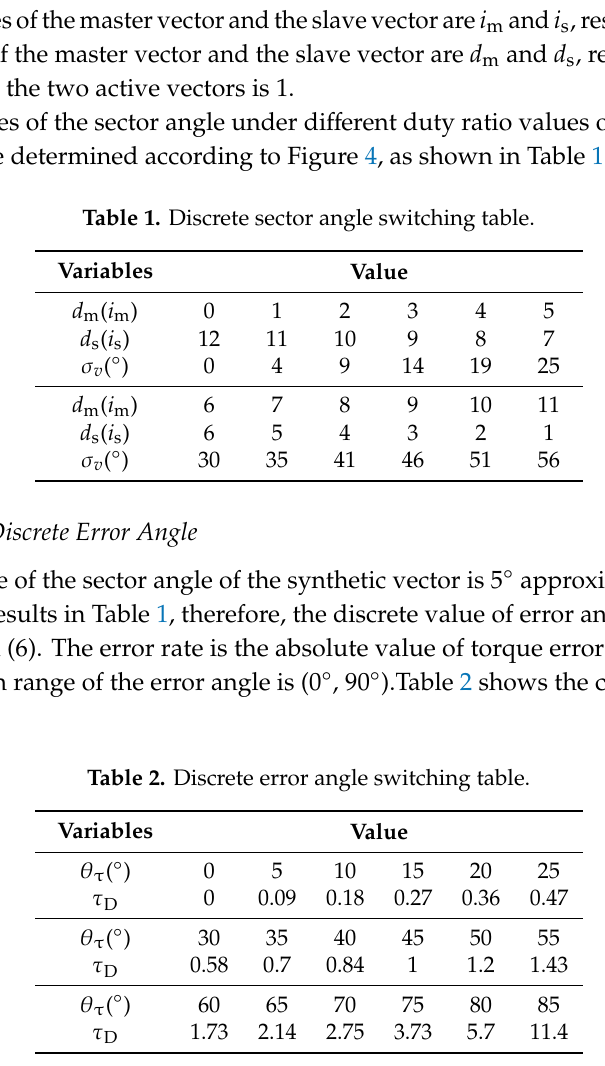
Figure 4. Diagram of discrete voltage vectors.